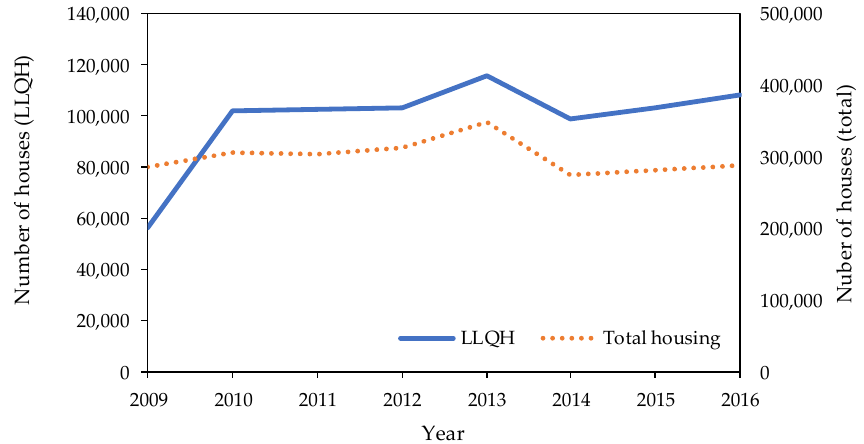
Figure 1. Number of houses (long-life quality housing (LLQH) and total housing) newly built in each year.